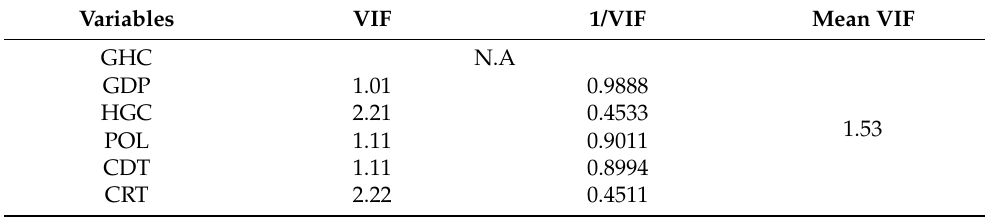
Table 5. VIF-test.